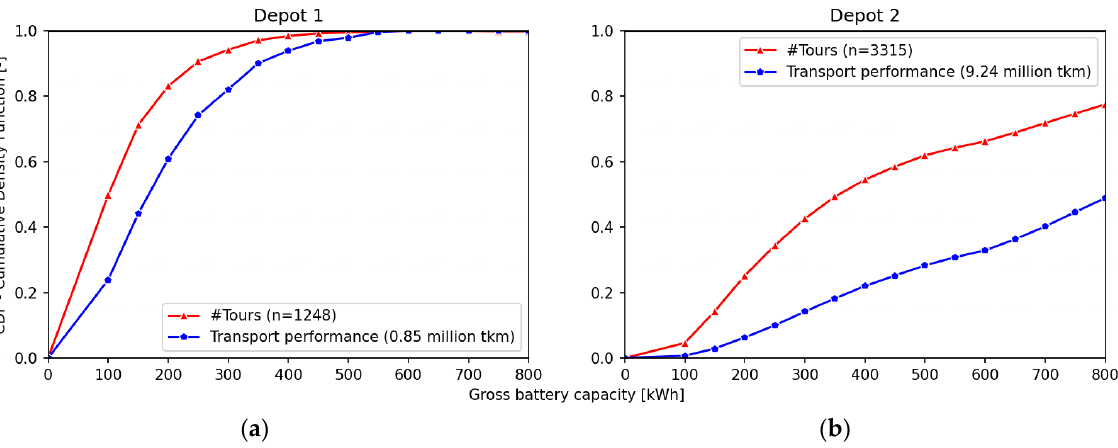
Figure 6. BET feasibility on tour- and tkm-level as CDF over gross battery capacity; ( a ) Depot1; ( b ) Depot2—own illustration.